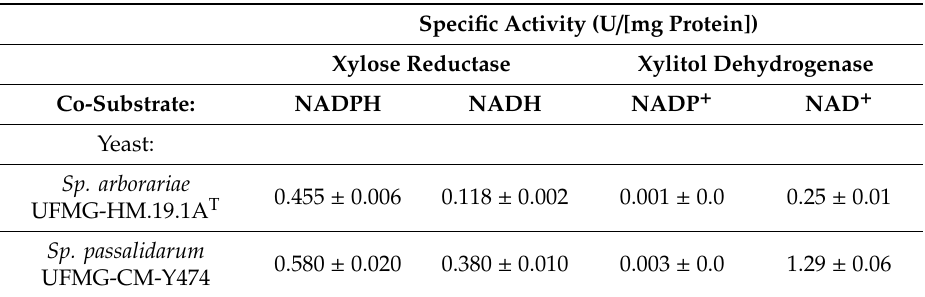
Table 2. Xylose reductase and xylitol dehydrogenase activities of selected Spathaspora